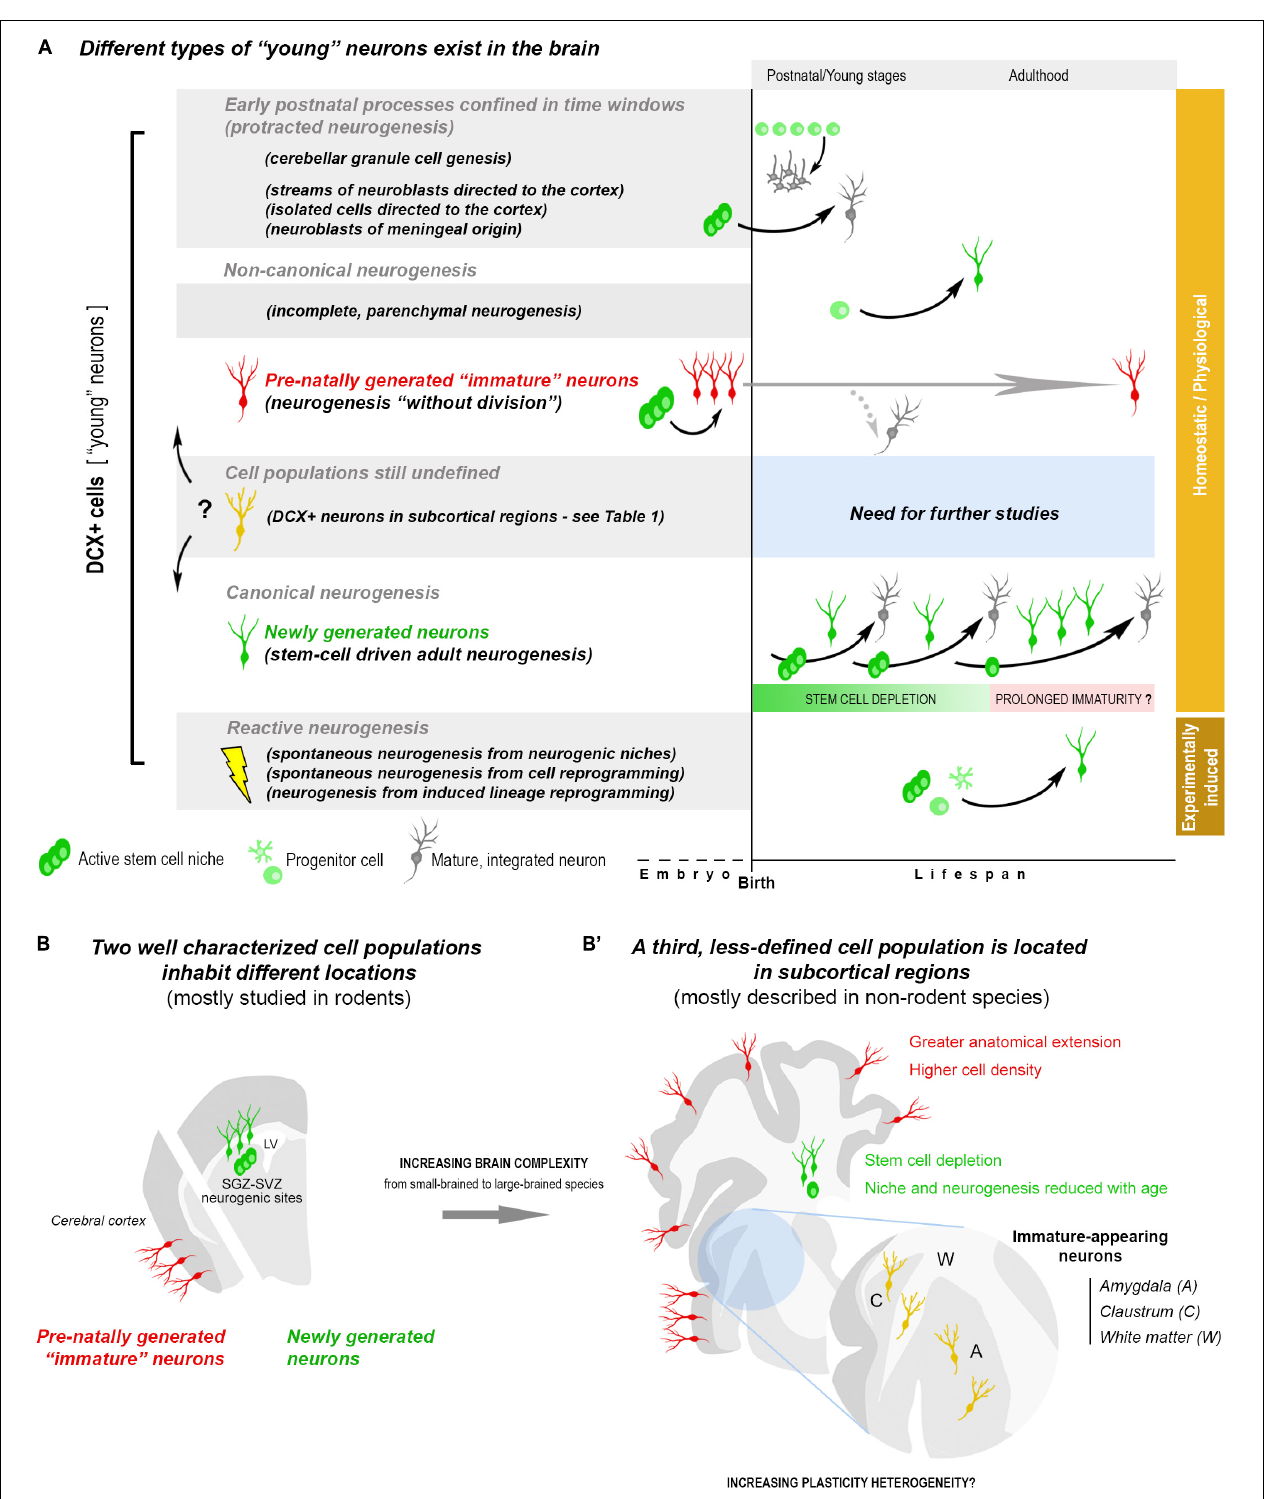
FIGURE 1 | Summary of the heterogeneity of “young,” undifferentiated neurons existing in the postnatal and adult mammalian brain, on the basis of the current knowledge. (A) Young neurons (e.g., DCX + cells) can belong to different cell populations, with different origin/fate, likely displaying different types of plasticity: postnatal streams of neuroblasts and postnatal genesis of neuronal populations; adult canonical and non-canonical neurogenic processes. Most of the young neurons can be considered as physiological/homeostatic events, others are reactive neurogenesis to lesion/disease (orange and brown on the right). Two cell